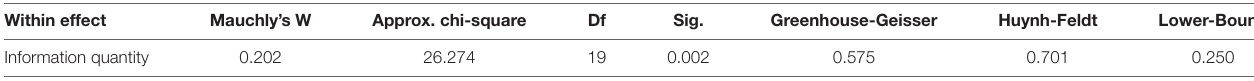
TABLE 12 | Mauchly’s test of sphericity.